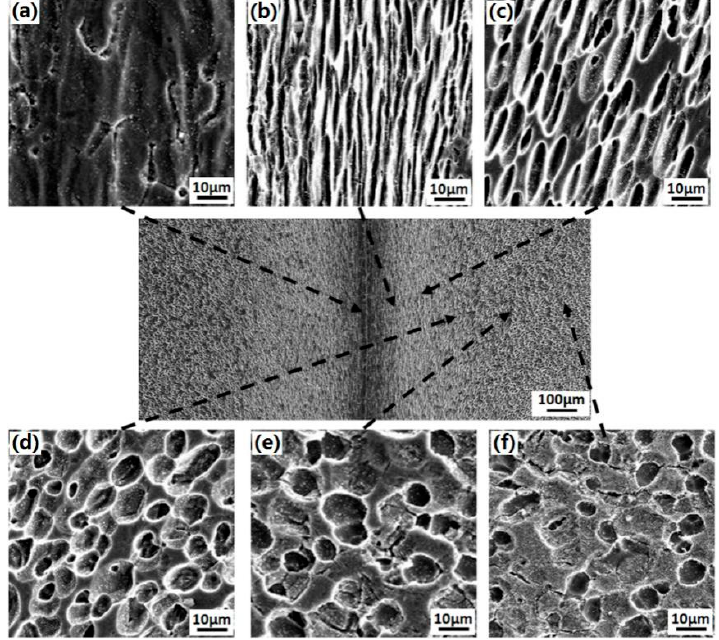
Figure 6. Microstructures in different zones of the as-welded Ti 3 Al LFW joint: ( a ) in WZ, ( b ) in TMAZ close to WZ, ( c ) in TMAZ, ( d ) in TMAZ close to BM, ( e ) in BM close to TMAZ, and ( f ) in the BM.